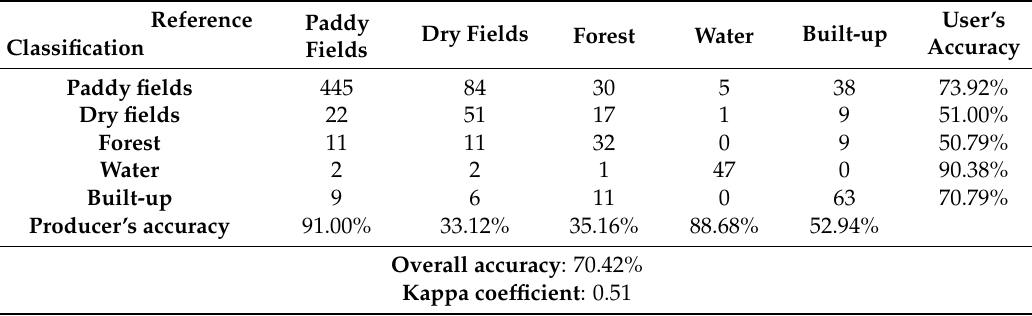
Table 3. Confusion matrix and accuracy statistics for classification using Radarsat-1 features.